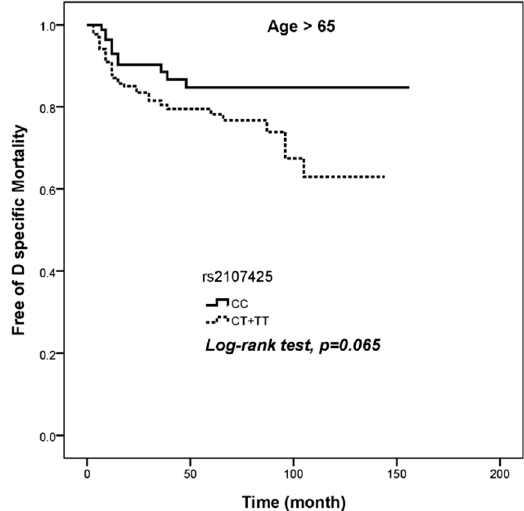
Bold font indicates statistical significance ( p < 0.05). The hazrds ratio (HR) with their 95% CI were estimated by Cox proportional hazards model. The adjusted hard ratio (AHR) with their 95% CI were estimated by multiple Cox proportional hazards model after controlling for age, sex, and tobacco consumption.